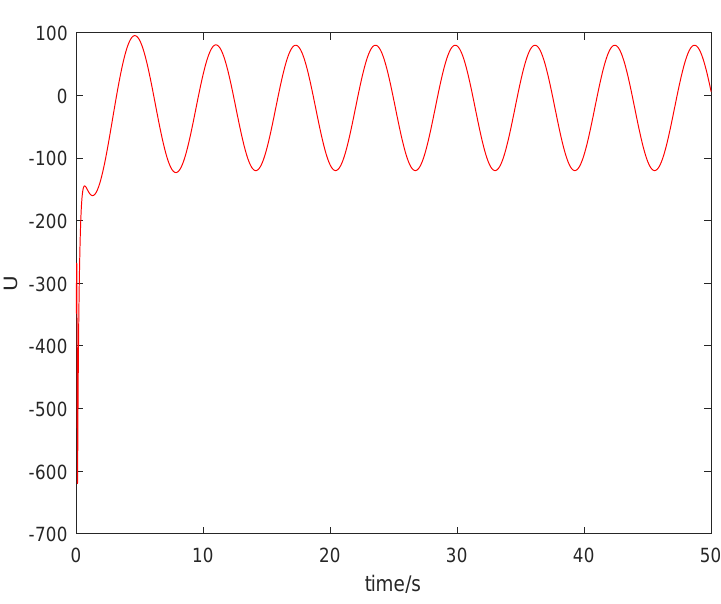
Figure 12. The state of control signal U ( t )